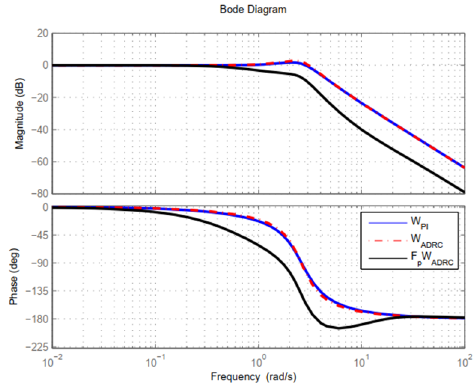
Figure 6. Typical Bode diagrams of W PI ( s ) , W ADRC ( s ) , and F P ( s ) W ADRC ( s ) . The parameters are: l 1 = 1, β 1 = 20, β 2 = 100, b 0 = 2. The plant P ( s ) = 2.25/ ( 1 + 1.5 ) 2 .